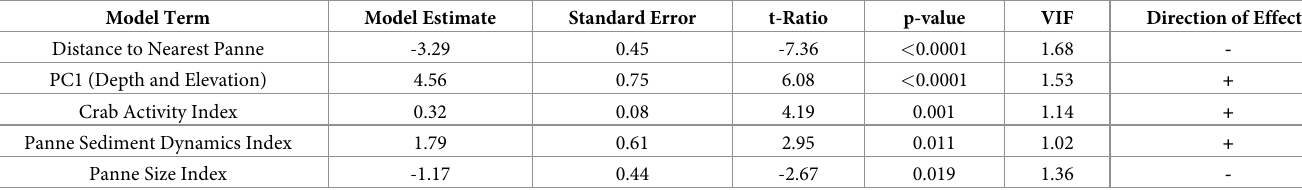
Table 2. Multiple regression model